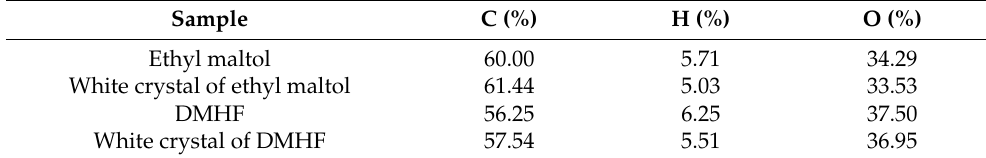
Table 2. The content of C, H, O in ethyl maltol, DMHF (calculation) and white crystals (measuring).